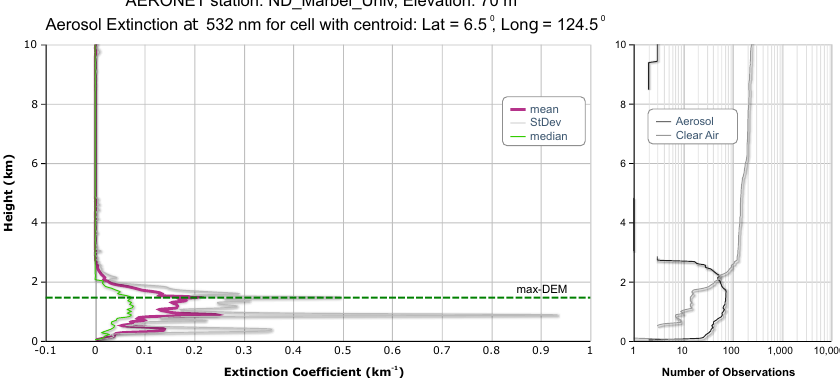
Figure 13. Example of high-slope terrain on CALIPSO overpasses for the case of the ND_Marbel_Univ AERONET station. Left panel: vertical distribution of the averaged aerosol extinction coefficient. Right panel: number of observations used in